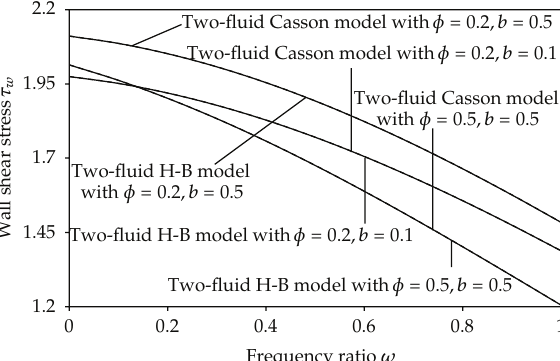
Figure 9: Variation of wall shear stress with frequency ratio for two-fluid H-B and Casson fluid models and di ff erent values of φ and b with t (cid:7) 60 ◦ , B (cid:7) 1, ψ (cid:7) − 0 . 1, β (cid:7) n (cid:7) 0 . 95, δ P (cid:7) 0 . 1, α (cid:7) α H (cid:7) α C (cid:7) 0 . 2, and z (cid:7) 2 . 3.